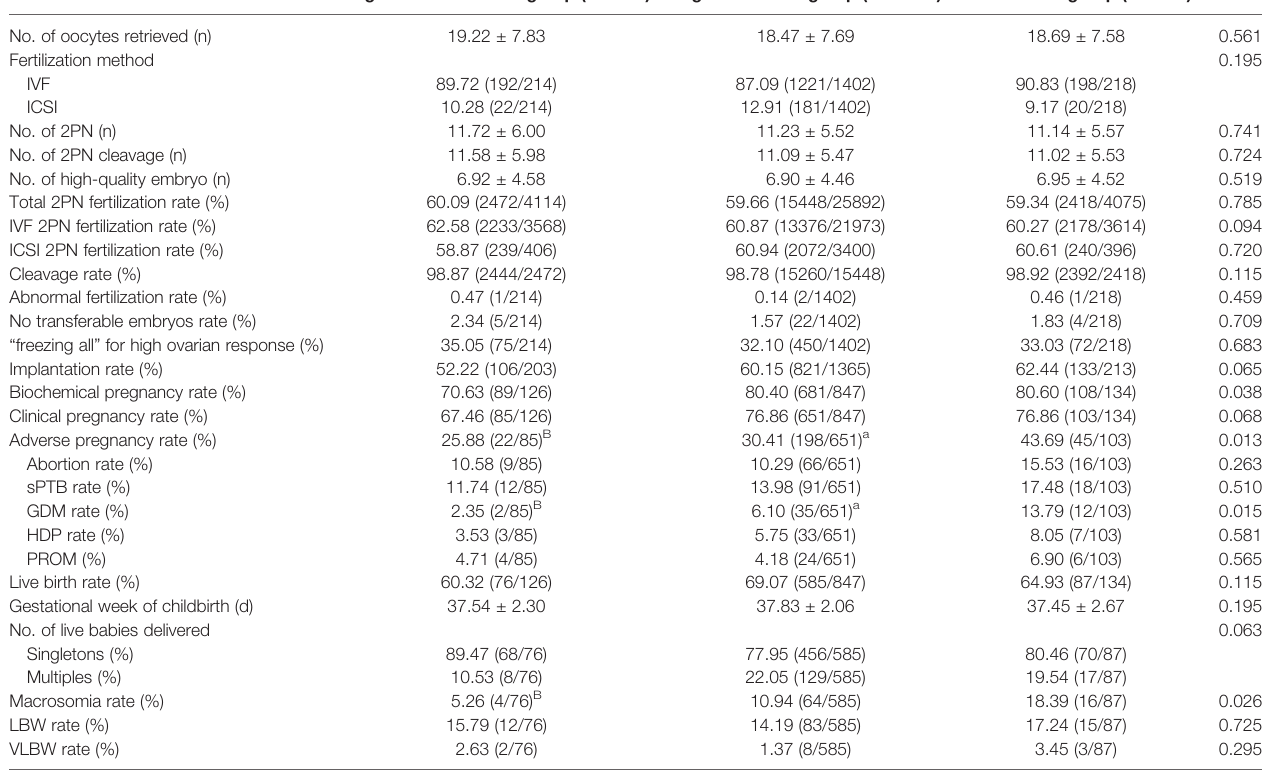
TABLE 2 | Laboratory results and clinical